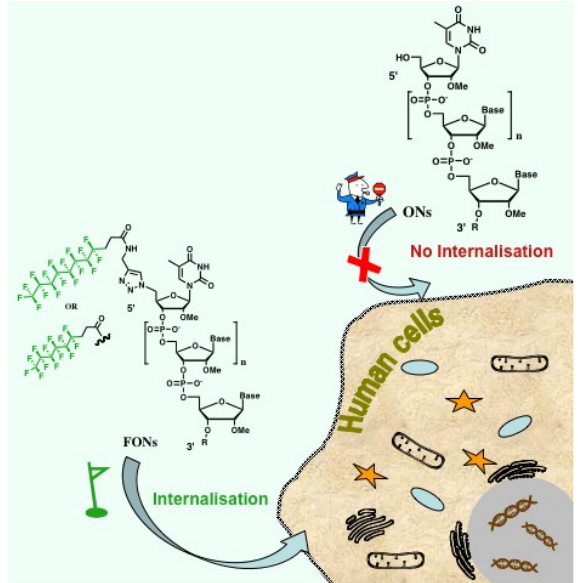
Figure 5. Conjugation of fluorocarbon chain to the oligonucleotide (FONs) allows the delivery of highly polyanionic oligonucleotides into human